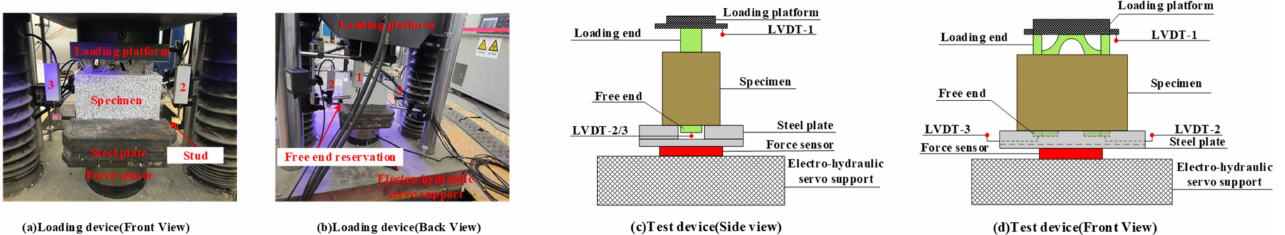
Figure 5. Push-out test device diagram.